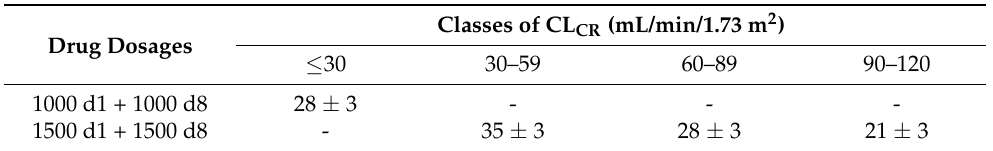
Figure 4. Simulated dalbavancin plasma concentration versus time profiles of a two-dosing regimen one week apart in different classes of renal function. The solid line is the simulated median concen- tration. The dashed lines are the 5th, 25th, 75th, and 95th percentiles of simulated concentrations. The horizontal dashed line is the threshold of concentration (8.04 mg/L) above which the desired pharmacodynamics target of f AUC 24h /MIC > 111.1 is granted over time. Table 3. Suggested timings (days) for assessing in a timely and cost-effective manner the TDM of dalbavancin in relation to the tested dosing regimens and CLCR